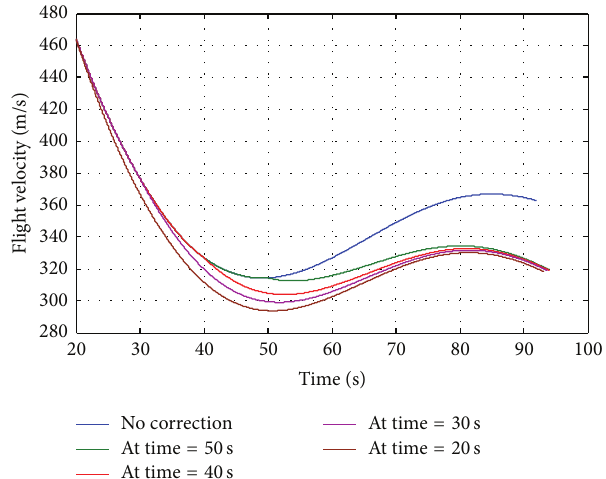
Figure 11: Flight velocity versus